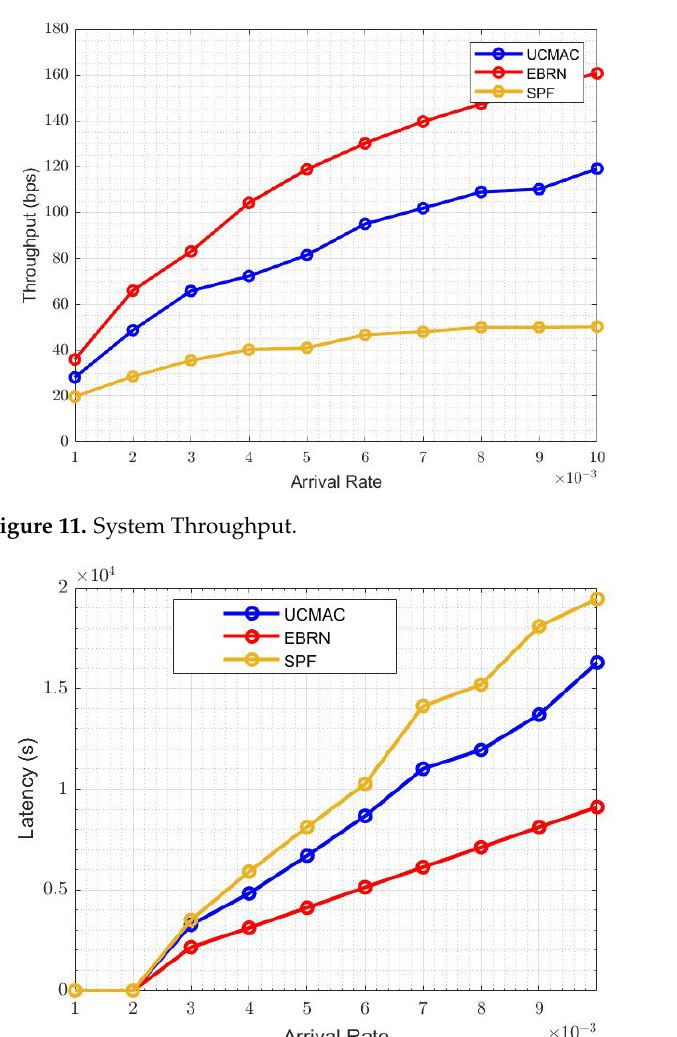
Figure 10. Number of retransmissions vs. Latency.